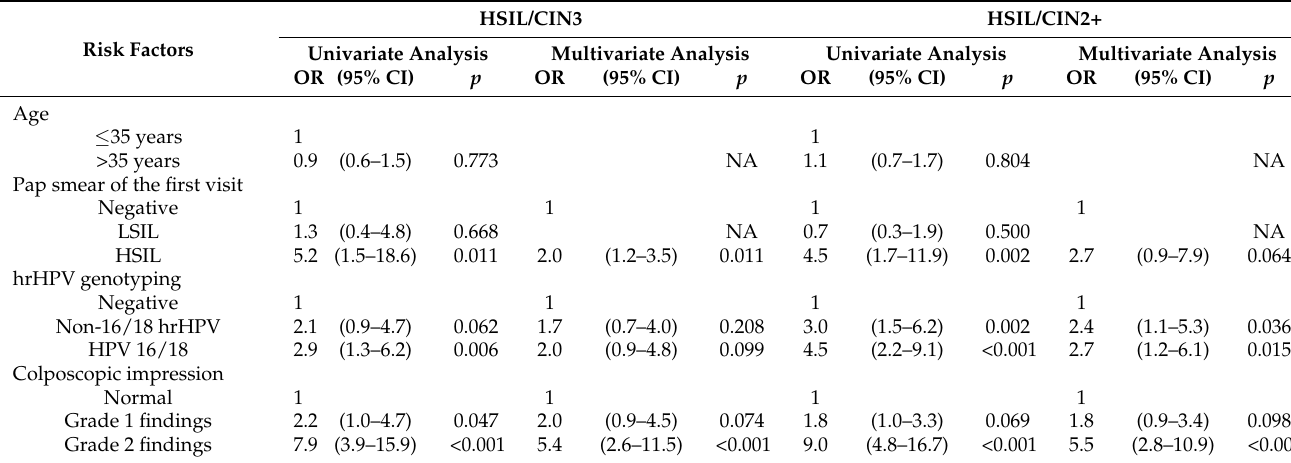
Table 4. Univariate and multivariate logistical regression analysis of risk factors associated with the diagnosis of high-grade cervical squamous intraepithelial lesions or worse HSIL/CIN2+ and HSIL/CIN3.